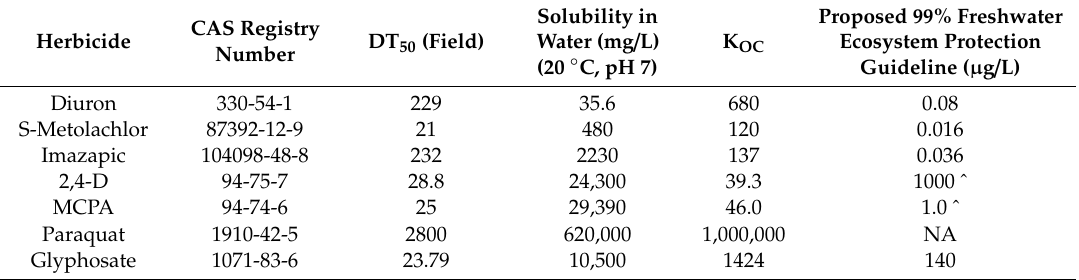
Table 5. Physico-chemical and toxicological properties * for herbicides utilised in the